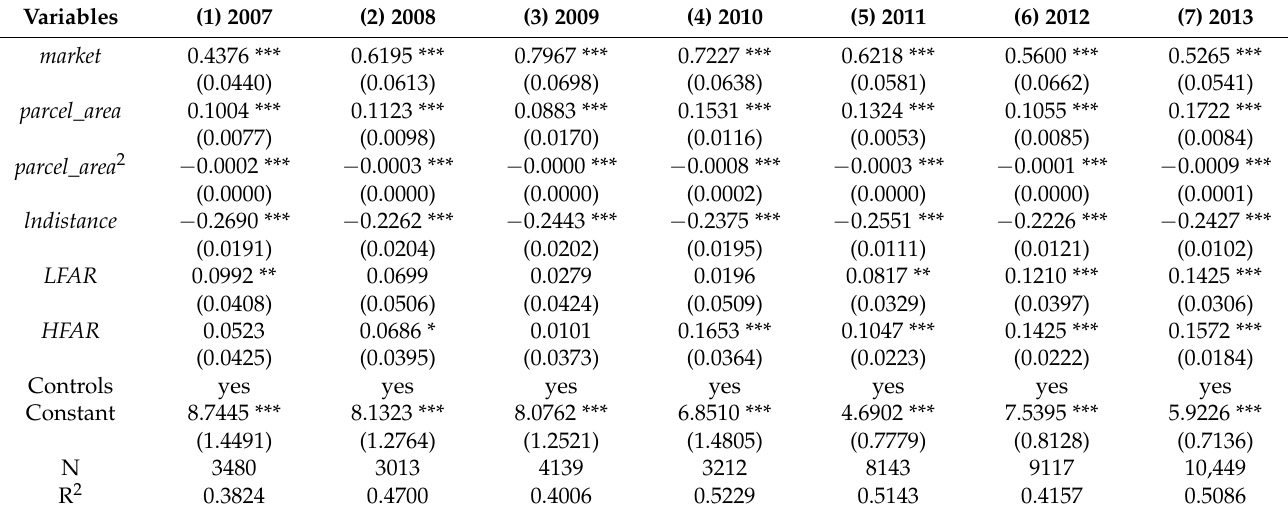
Table 4. Impact of market-based transfer modes on industrial land